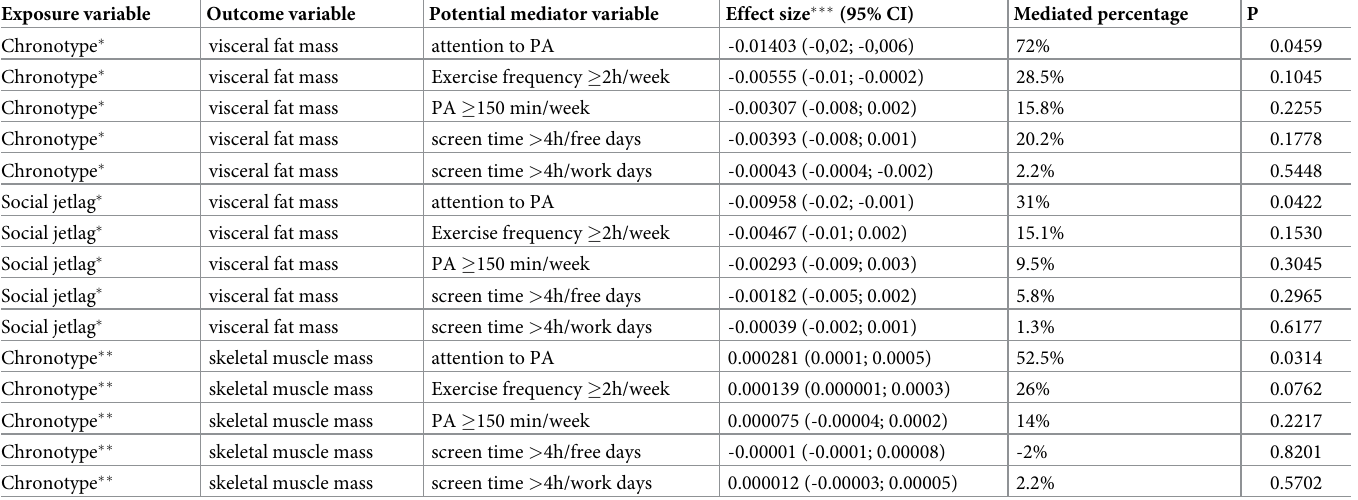
Table 3. Mediation analysis of the relevance of selected physical activity variables (potential mediators) for the association of chronotype/social jet lag with visceral fat / skeletal muscle mass (kg) among participants of the baseline survey (n = 320). Exposure